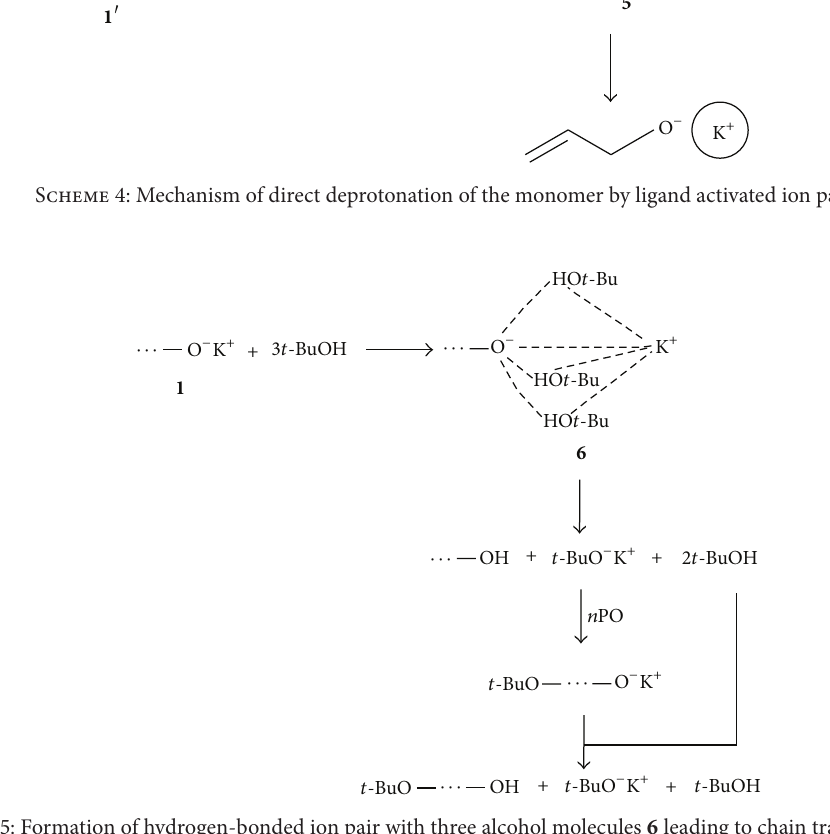
Scheme 7: Cation exchange reaction between polymer